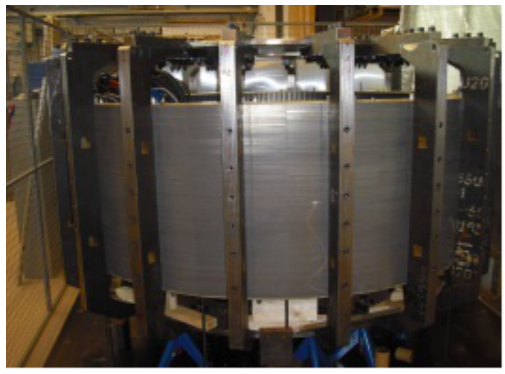
Figure 5. A direct driven three phase 225 kW permanent magnet synchronous cable wound